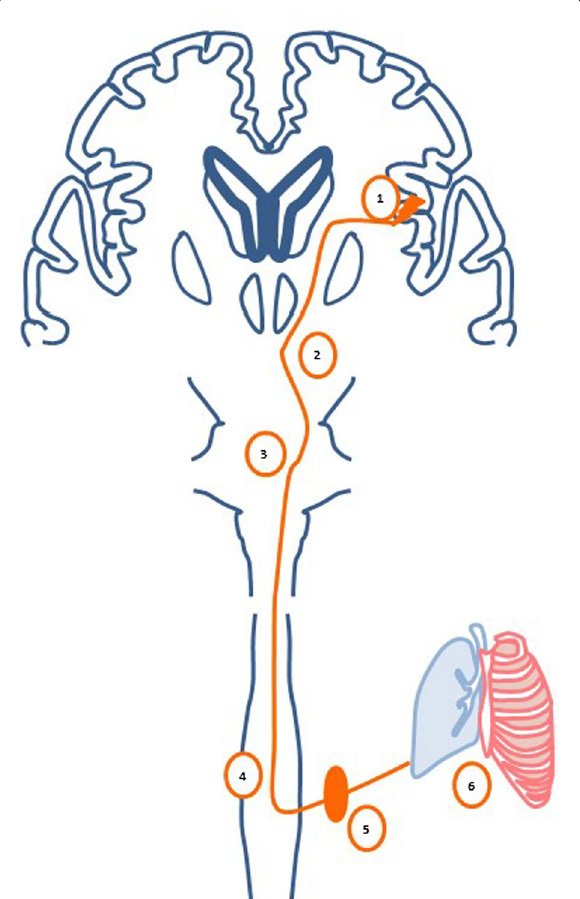
Fig. 1 Involuntary control of breathing: Structures: 1. Anterior portion of the insular cortex; 2. Hypothalamus; 3. Stem centers: pneumotaxic center of the pons and ventral and dorsal respiratory groups of the pontobulbars (nucleus ambiguus and solitary nucleus, respectively), locus coeruleus; 4. Intermediolateral column of the spinal cord; 5. Superior cervical ganglion; 6. Bronchioalveolar receptors and accessory muscles of respiration. Control mechanism: The peripheral chemoreceptors of the carotid bulbs and aortic arch innervated by the glossopharyngeal nerve (activated by hypoxia, increased CO 2 , decreased arterial pH or hypoperfusion), project to the nucleus of the solitary tract, and this, together with the locus coeruleus, are central sensors of CO 2 concentrations. These afferent nuclei plus the efferent nuclei in the ventral and dorsal pontobulbar groups have descending pathways to the intermediolateral column of the spinal cord, which contains sympathetic preganglionic neurons, in turn making efference through the superior cervical ganglion to the bronchi, alveoli, and accessory muscles of respiration. The structures of the indicated stem and the lateral intermediate column of the spinal cord receive superior control from the insula and hypothalamus, with sympathetic and parasympathetic autonomic control, which, when altered by central lesions, lead to the alteration of the predominantly sympathetic respiratory cycle. Created by